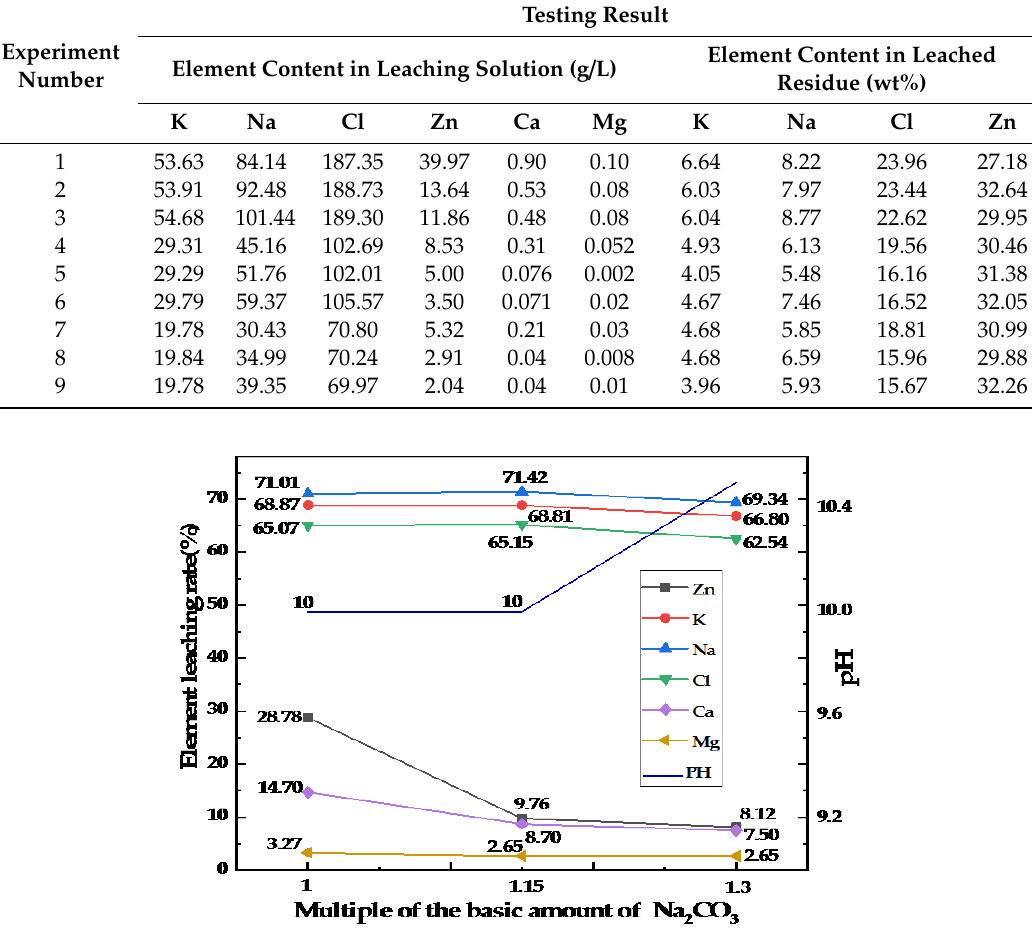
Figure 5. Leaching ratios of various elements with different Na 2 CO 3 additions at a liquid–solid ratio of 2:1.